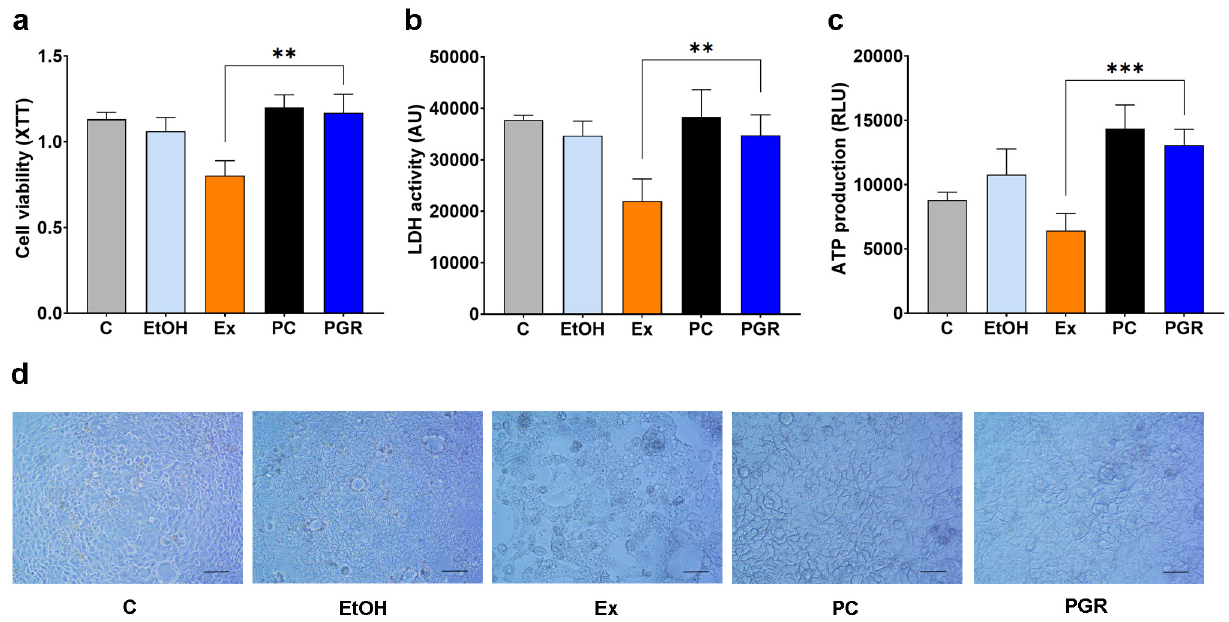
Figure 5. Viability of Caco-2 enterocytes after incubation with PHYTOGINROSA (PGR) compared to phosphatidylcholine (PC), hydroalcoholic extracts (Ex) or ethanol (EtOH). Cell viability (XTT) ( a ), LDH activity ( b ) and intracellular ATPs level ( c ). The results are presented as means ± SD. ** p < 0.01, *** p < 0.001 for PGR versus Ex. Light microscopy images depicting the cellular density of Caco-2 cells after exposure to control media (C), EtOH, Ex, PC or PGR ( d ); scale bar—50 µm.